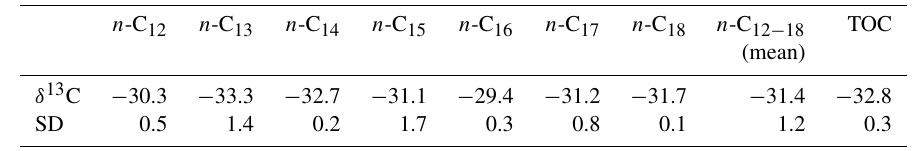
Table 1. Stable carbon isotopic composition ( δ 13 C) of the total organic carbon (TOC) and n -alkanes released from high-temperature HyPy of the Dresser kerogen. n -C 12 n -C 13 n -C 14 n -C 15 n -C 16 n -C 17 n -C 18 n -C 12 − 18 TOC (mean) δ 13 C − 30.3 − 33.3 − 32.7 − 31.1 − 29.4 − 31.2 − 31.7 − 31.4 − 32.8 SD 0.5 1.4 0.2 1.7 0.3 0.3